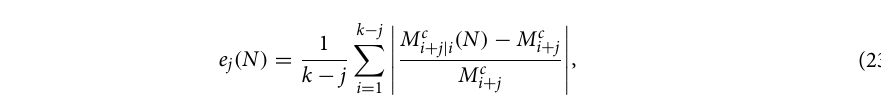
Figure 2. The forecasting of the epidemic trend of I ( t ) with different population